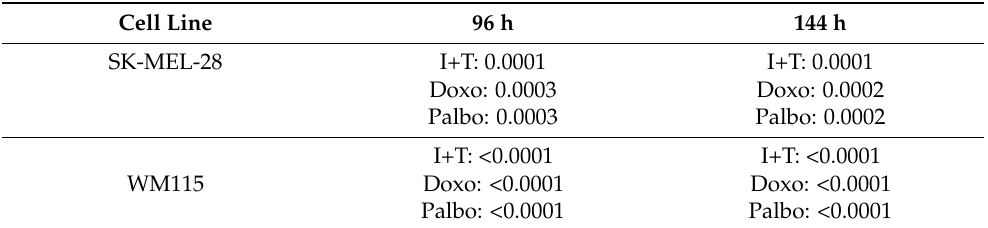
Table A1. Statistical analysis of the cell cycle analysis (Figure 4d,e) using two-way ANOVA shows a significant difference between the S phase of each treatment at both time points when compared to the S phase of the respective controls. The table indicates the p -value of each analysis.